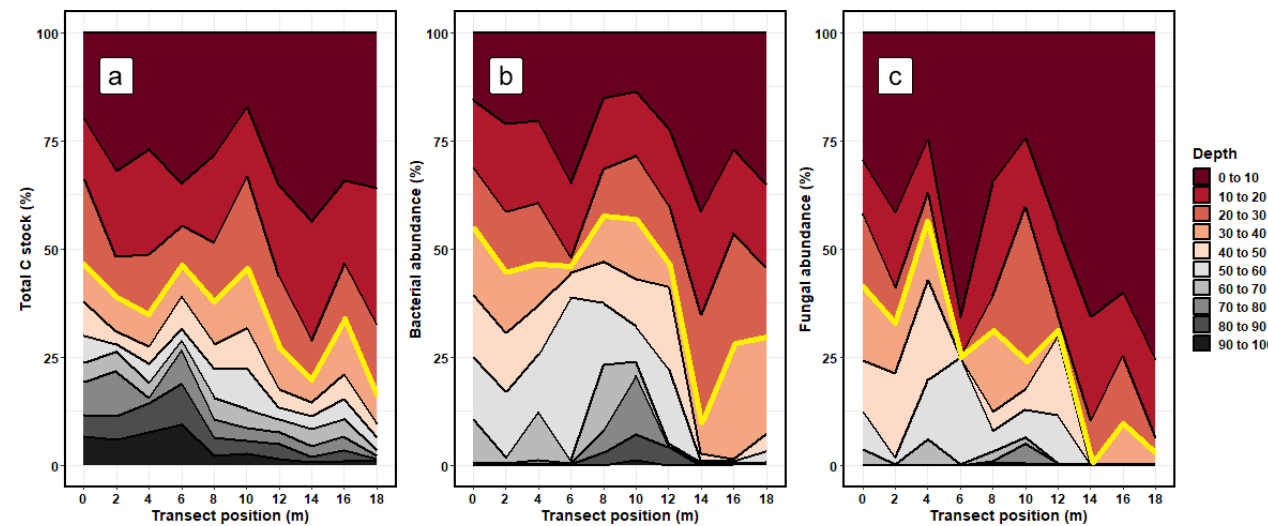
Figure 1. The relative proportion (%) of (a) total carbon stocks (CMgha − 1 ), (b) bacterial DNA abundance, and (c) fungal DNA abundance allocated to each depth increment. The values for soil C stocks are reported using the sum of < 2 and > 2mm soil fractions. The transect position ( m ) shows where each soil core was extracted from along the sampling transect. The red line shows the typical cutoff point of the topsoil subsoil boundary, where measures below 30cm are rarely